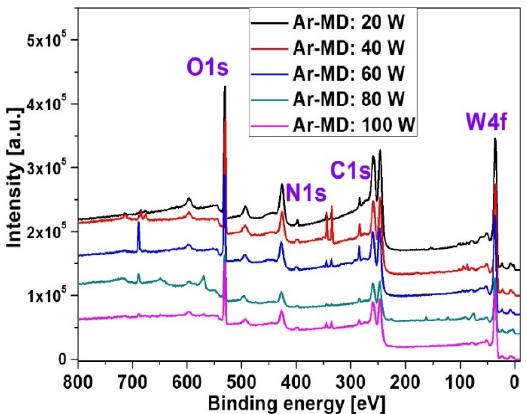
Figure 18. XPS Survey spectra of particles obtained in Ar-MD configuration.